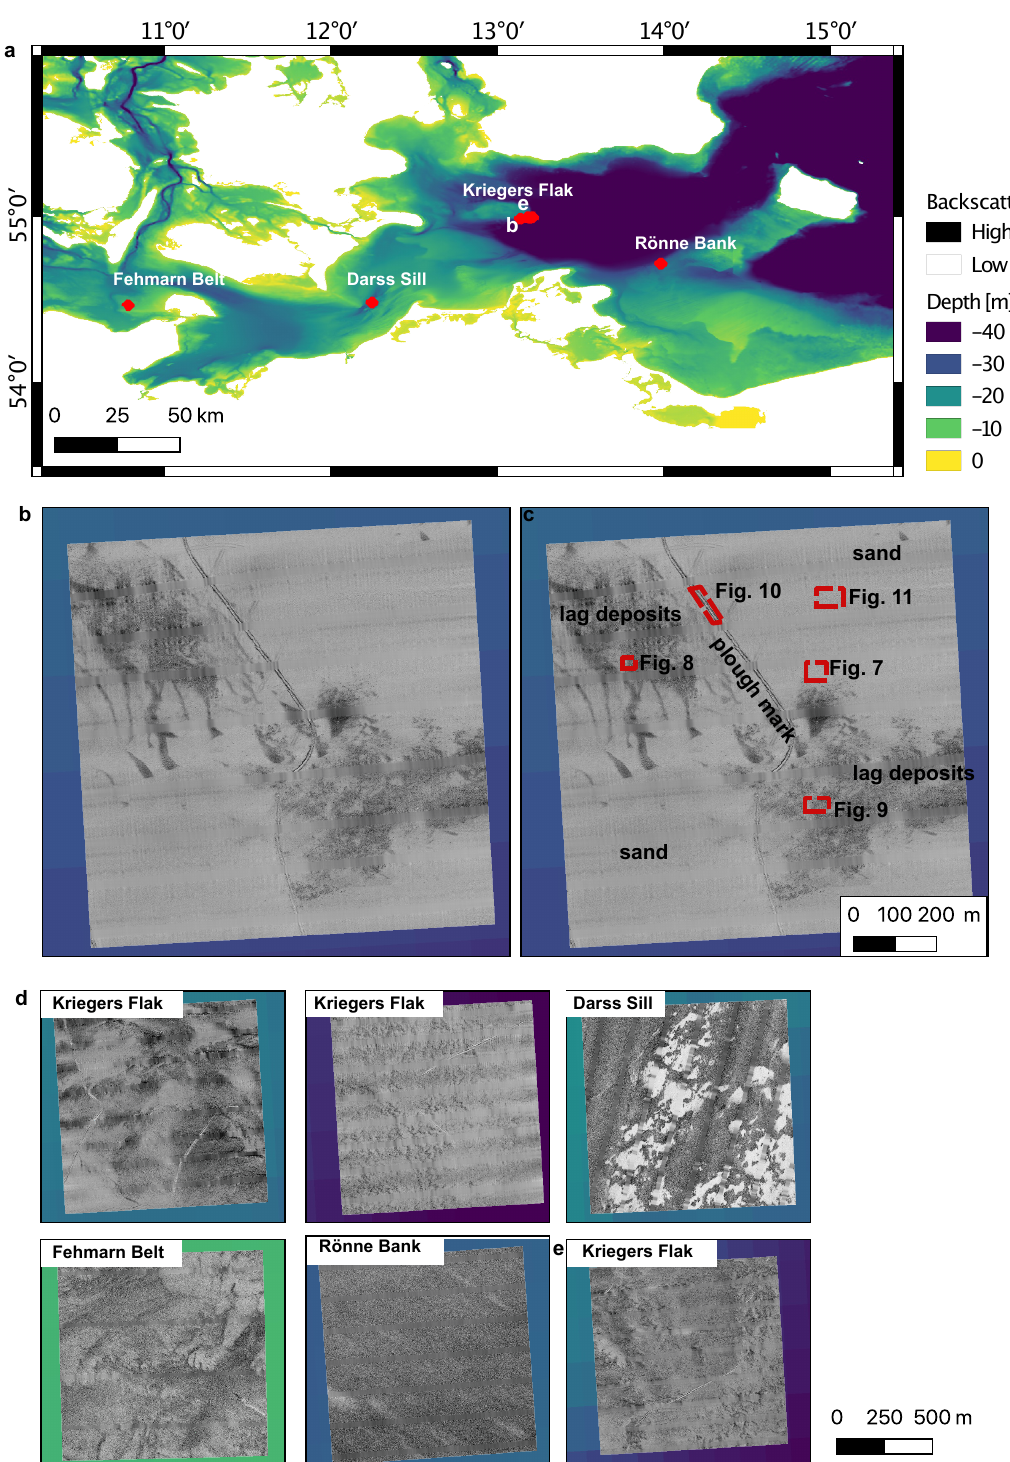
Figure 1. ( a ) Location of the mosaics used for validation and training of the super resolution and object detection model. Areal extension of mosaics is enlarged. ( b ) Validation mosaic. ( c ) Annotated validation mosaic. ( d ) Mosaics used for training of the super resolution model. ( e ) Mosaic used for training of the object detection model. The mosaic was also part of the super-resolution training suite. The native resolution of all mosaics is 0.25 m. Colors in ( a – e ) correspond to the depth